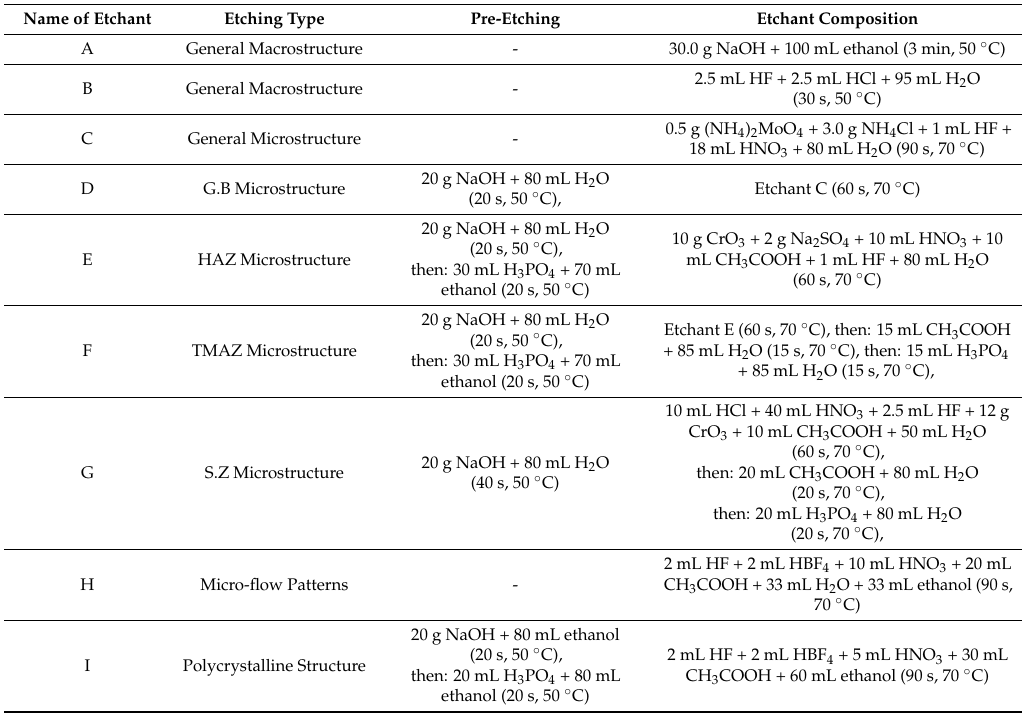
Table 3. Different groups of reagents with separate sequences of